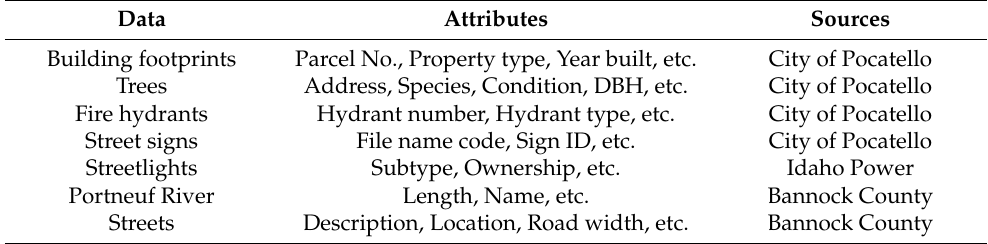
Table 1. Vector data sources.